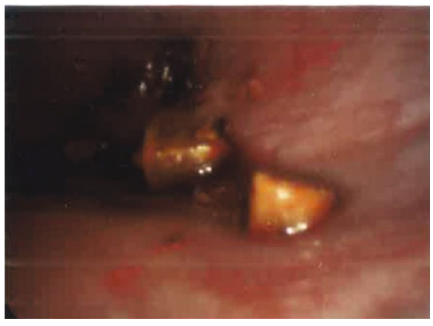
Figure 3: Deeply embedded multiple fragments of stone-like material in peritoneal